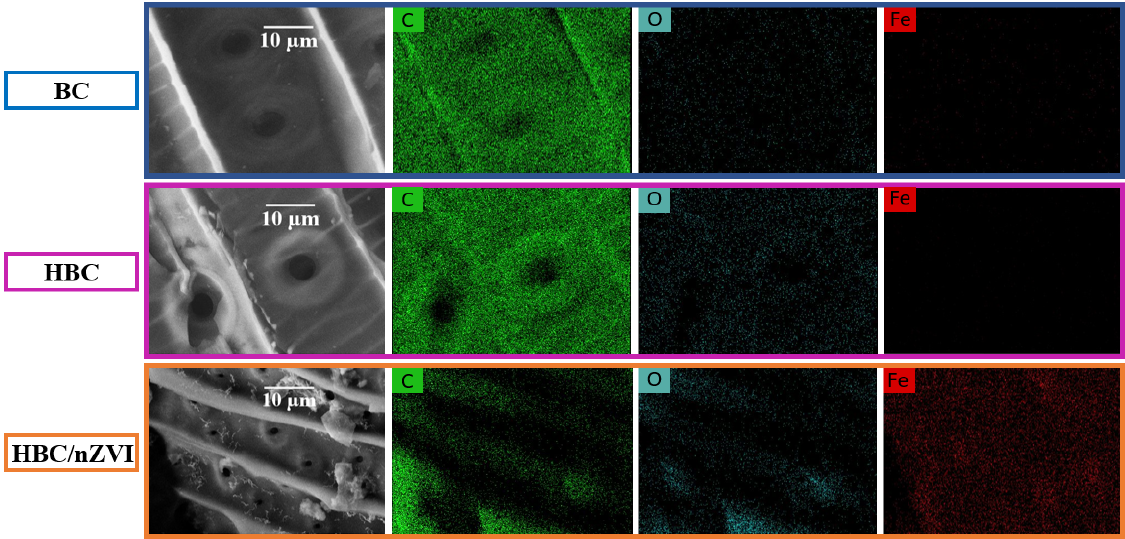
Figure 2. Elemental maps from the EDS analysis of BC ( first row ), HBC ( middle row ), and HBC/nZVI ( bottom row ), assigning green to carbon, cyan to oxygen, and red to iron.